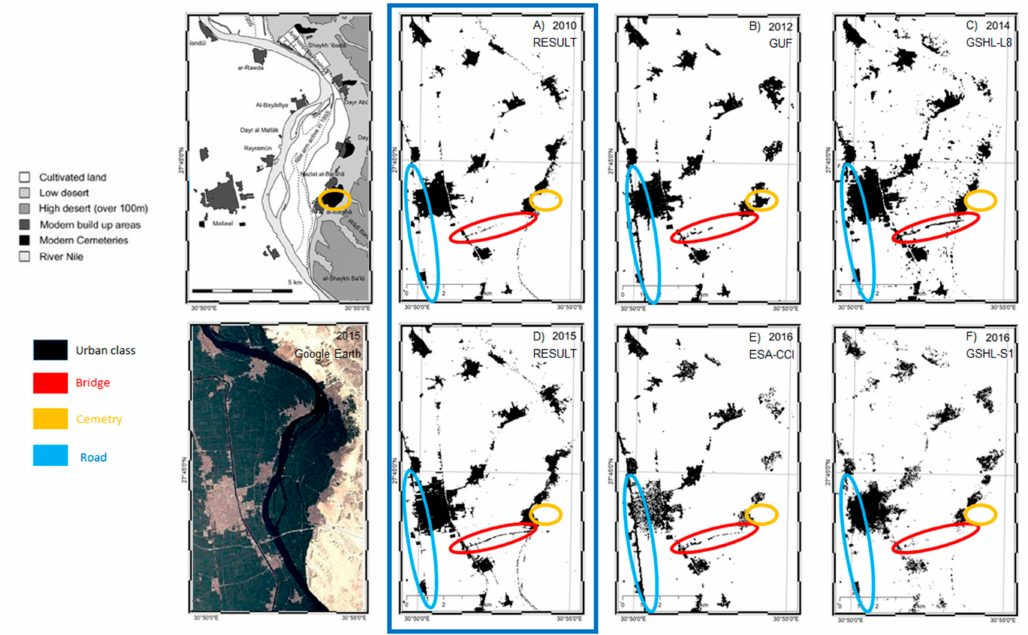
Figure 10. Urban / built-up of Mallawi city and surroundings from the di ff erent datasets: ( A ) 2010, this study, ( B ) GUF for 2012, ( C ) GHSL-L8 2014, ( D ) 2015, this study, ( E ) ESA-CCI Prototype 2016 and ( F ) GHSL-S1 2016. Top left map showing the location of modern cemeteries [55]. In colour circles di ff erent areas highlighting di ff erent classification performances. The blue rectangle highlights our